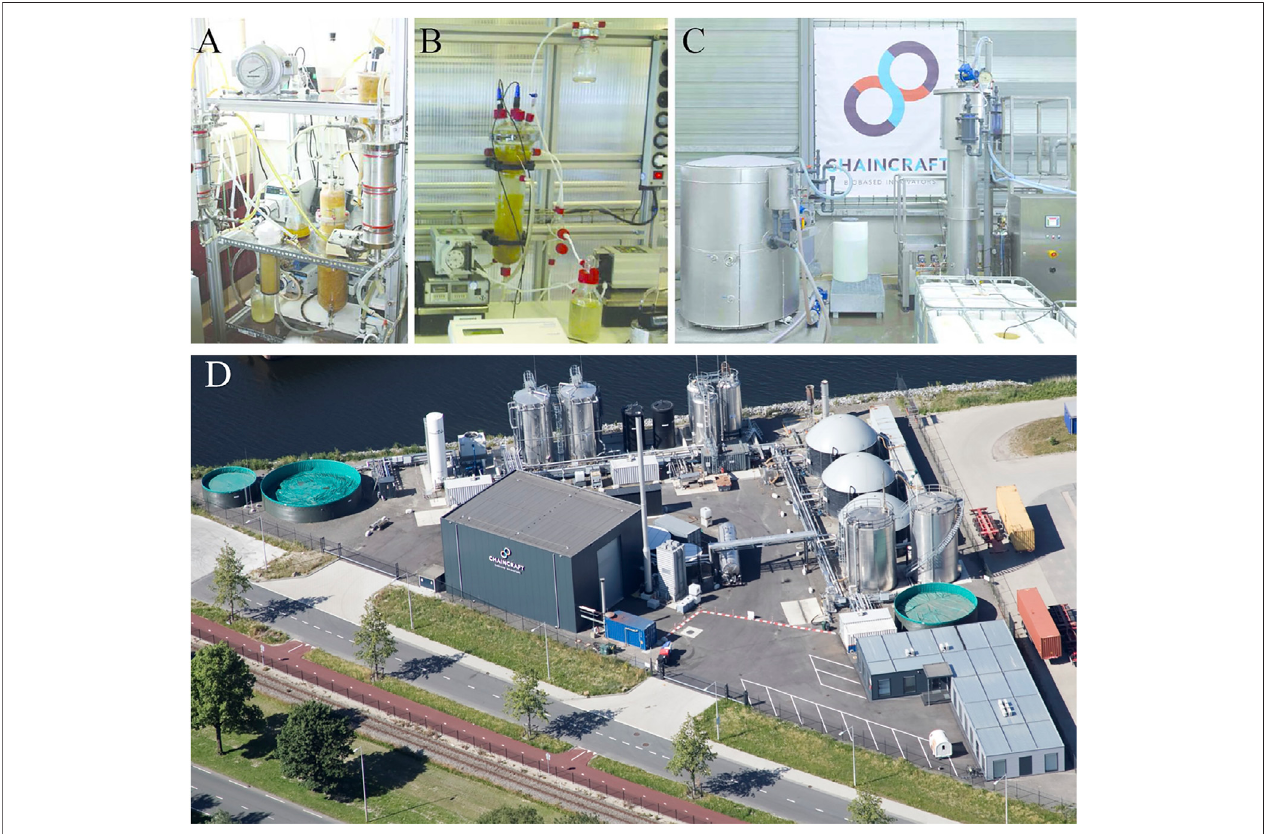
FIGURE 1 | Chain elongation bioreactor developments. Technology Readiness Level (TRL) emerged from lab TRL 2 to 4 (A,B) to pilot TRL 5 to 6 (C) , and to demonstrationTRL7to8 (D) :plantoperatedbyChainCraft,Amsterdam,Netherlands). ABC:Reprintedwithpermissionfrom (Angenentetal.,2016) withcopyright2016 American Chemical Society. D: kindly provided by